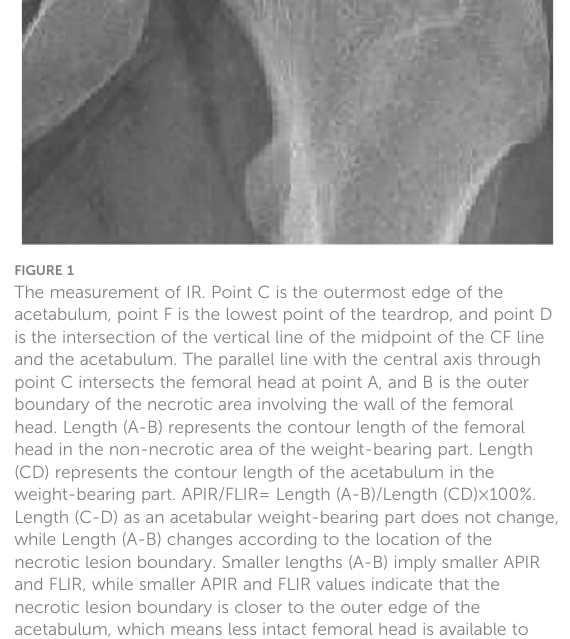
weight-bearing part. APIR/FLIR= Length (A-B)/Length (CD)×100%. Length (C-D) as an acetabular weight-bearing part does not